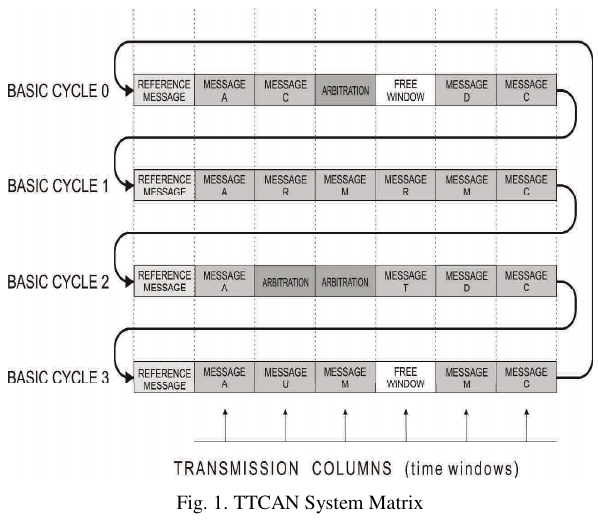
Fig. 1. TTCAN System